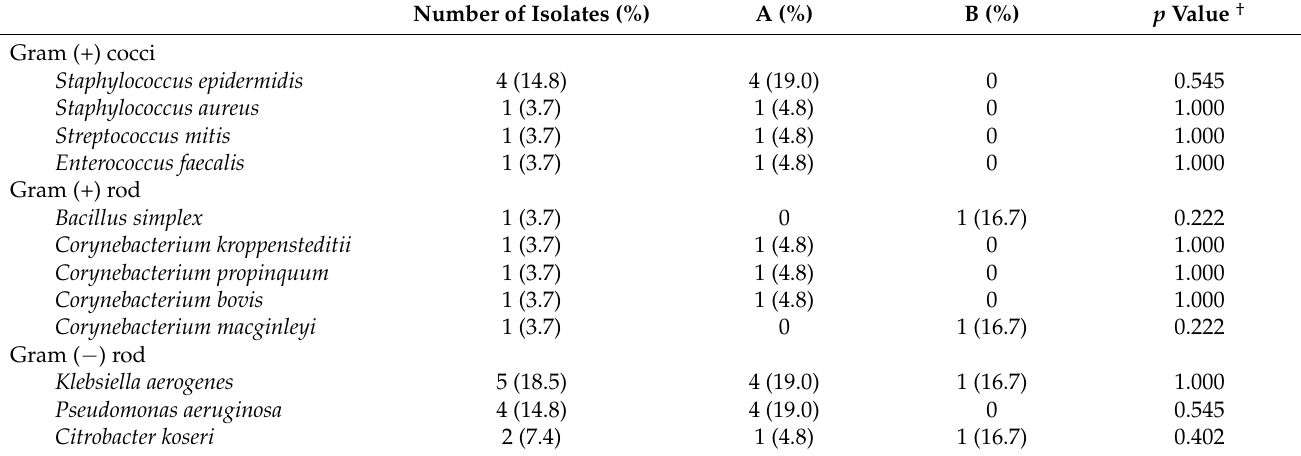
Table 4. Cultured bacterial isolates from removed punctal